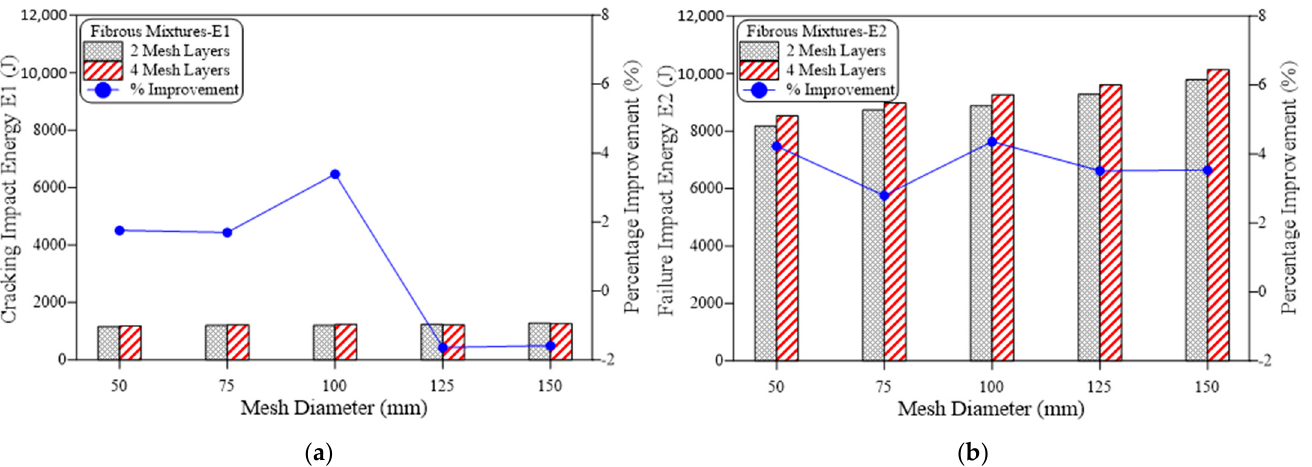
Figure 7. Effect of number of mesh layers on impact energy of fibrous mixtures, ( a ) cracking energy E1, ( b ) failure energy E2.